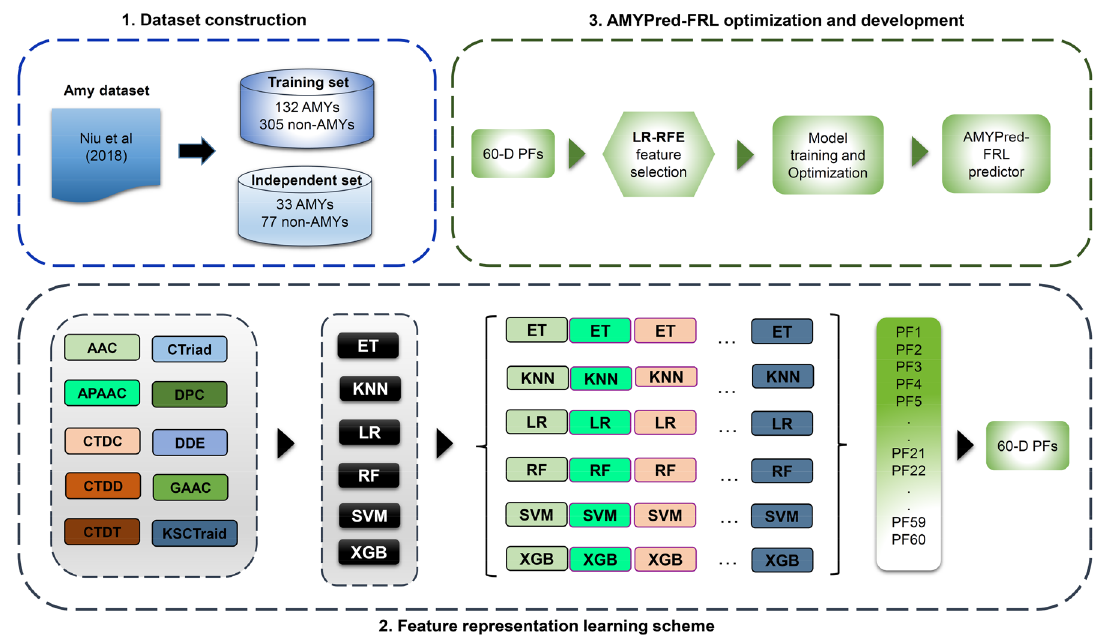
Figure 1. Schematic flowchart of the development of the AMYPred-FRL. It consists of dataset construction, feature extraction, baseline models construction and the final meta-based model